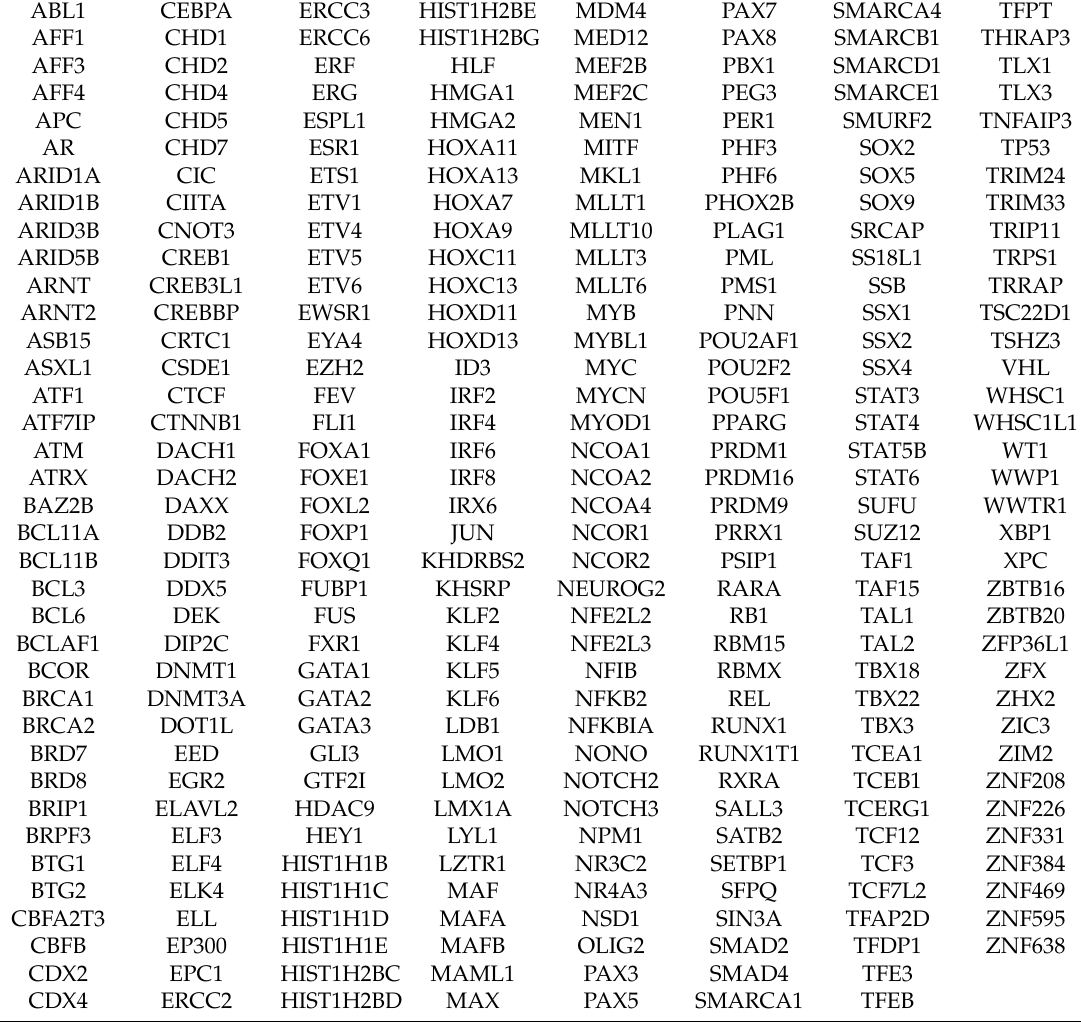
Table 1. List of the 294 known or candidate oncogenic transcription factors and regulators 1